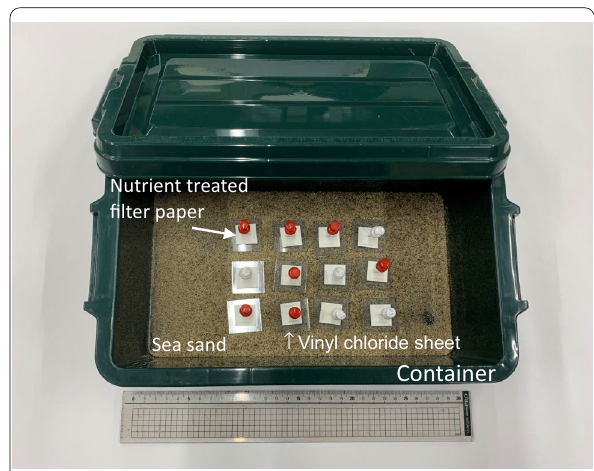
Fig. 1 Test chamber for multiple-choice feeding